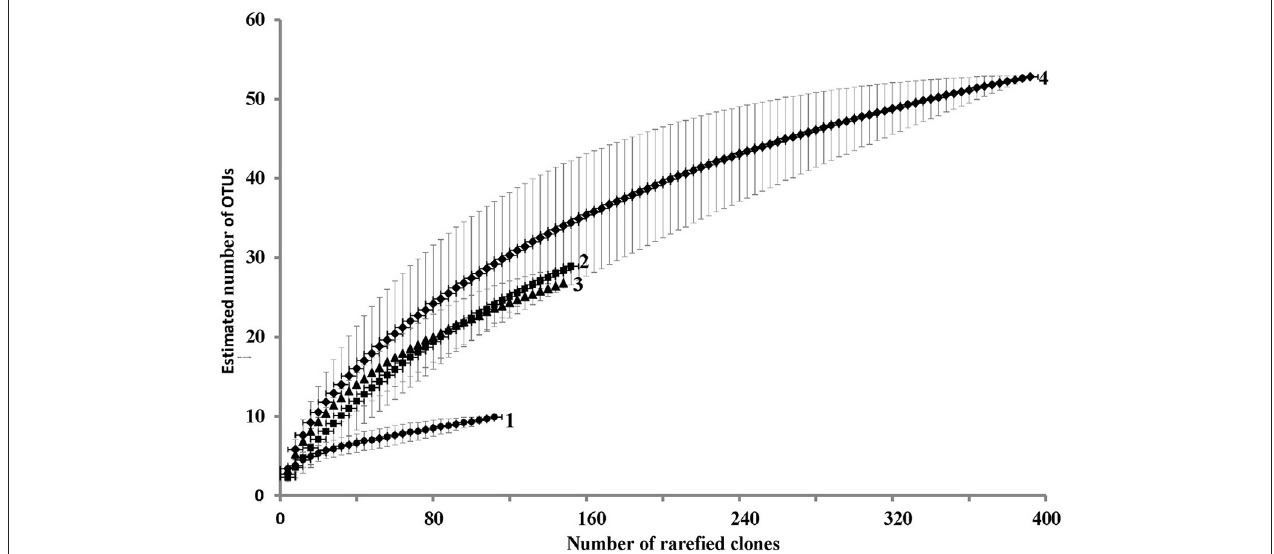
FIGURE 1 | Rarefaction curves based on the results of comparison of the number of cloned 16S rRNA gene sequences and phylotypes in the DNA-derived clone libraries of Archaea (DA library, curve 1, 115 clones), in the DNA-derived library for Bacteria (DB, excluding planctomycetes, curve 2, 153 clones), in the RNA-derived library of Bacteria cDNA of 16S rRNA sequences (DR, curve 3, 151 clone), and in the total 16S rRNA gene library [DB + DP (89 clones)] + cDNA of 16S rRNA sequences of Bacteria (RB), curve 4, 393 clones. The sequences were grouped in phylotypes at the level of 97% between the sequences of the 16S rRNA genes or cDNA of 16S rRNA transcripts.